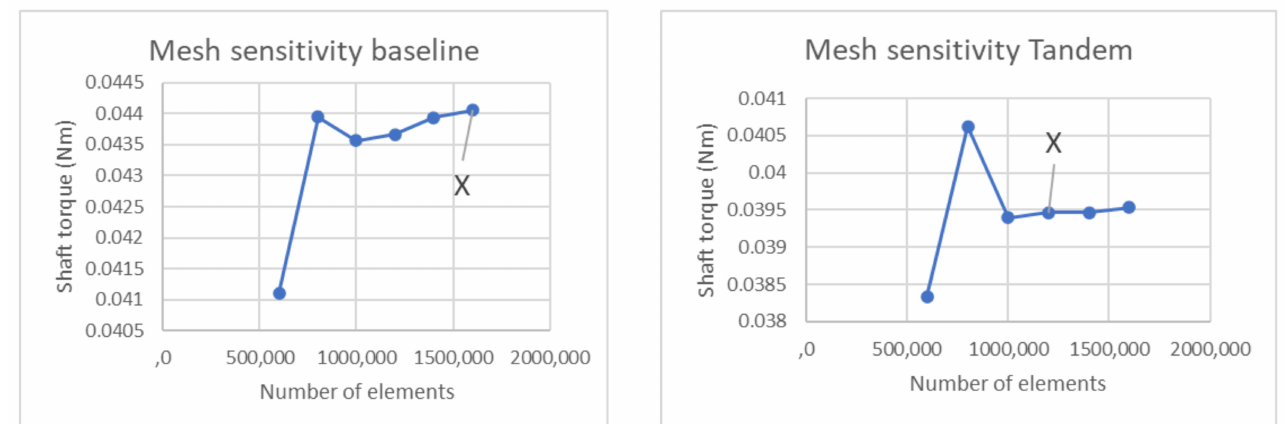
Figure 11. Mesh sensitivity for the conventional ( left ) and tandem compressor ( right ).